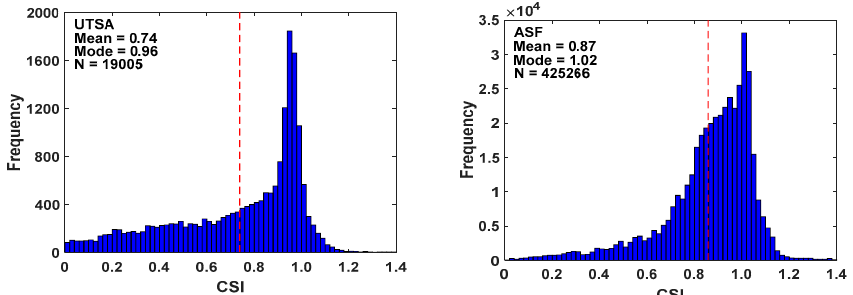
Figure 3. Histograms of the clear sky index (CSI) from all available ground data at their original sampling rates measured at the two study locations (UTSA and ASF), with the red dashed lines indicating the CSI